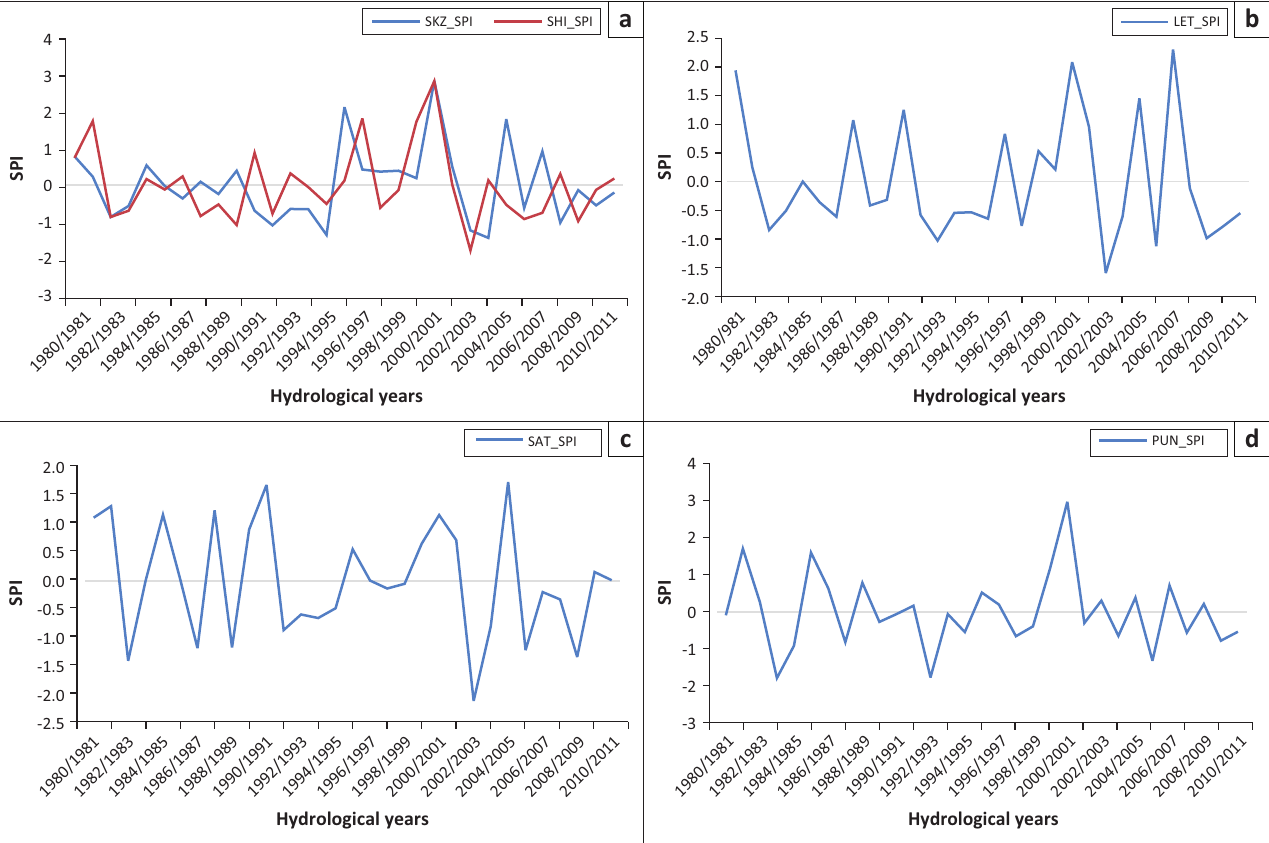
SKZ, Skukuza; SPI, Standardised Precipitation Index; SHI, Shingwedzi; LET, Letaba; SAT, Satara; PUN, Punda Maria. FIGURE 4: Kruger National Park Standardised Precipitation Index. (a) Skukuza and Shingwedzi Standardised Precipitation Index, (b) Letaba Standardised Precipitation Index, (c) Satara Standardised Precipitation Index and (d) Punda Maria Standardised Precipitation